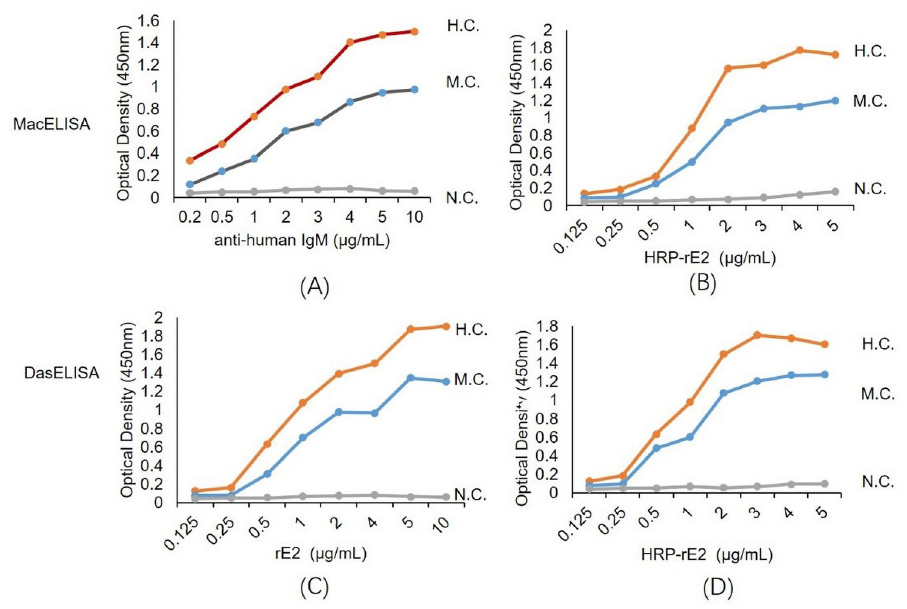
Fig 2. Determination of the optimal concentrations of key components of the Mac-ELISA and Das-ELISA.